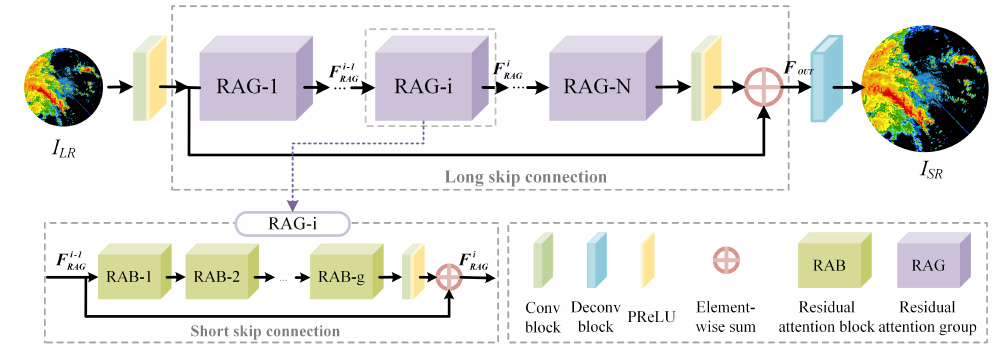
Figure 3. The structure of residual attention back-projection